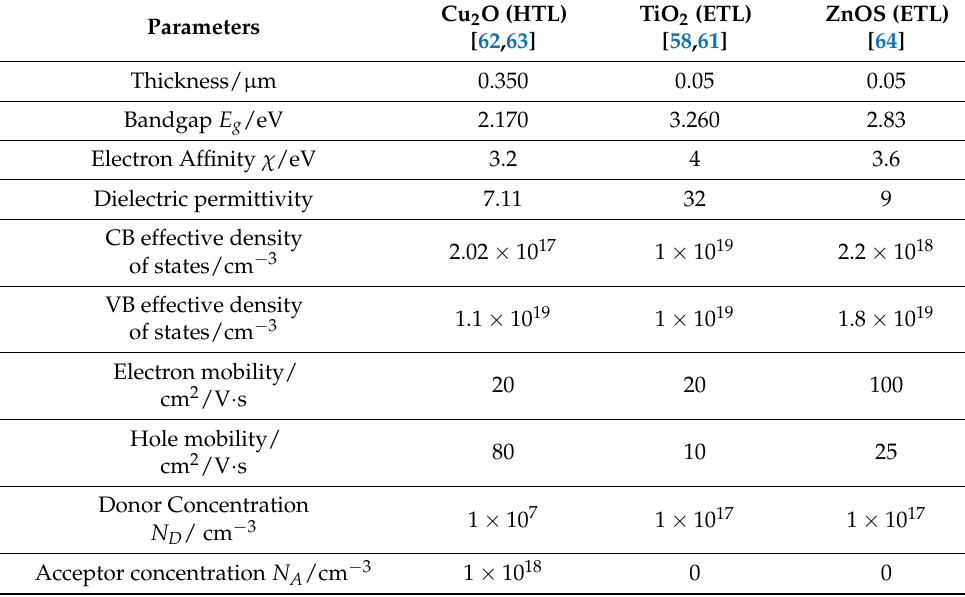
Table 2. Electrical and optical properties of different ETL and HTL materials.